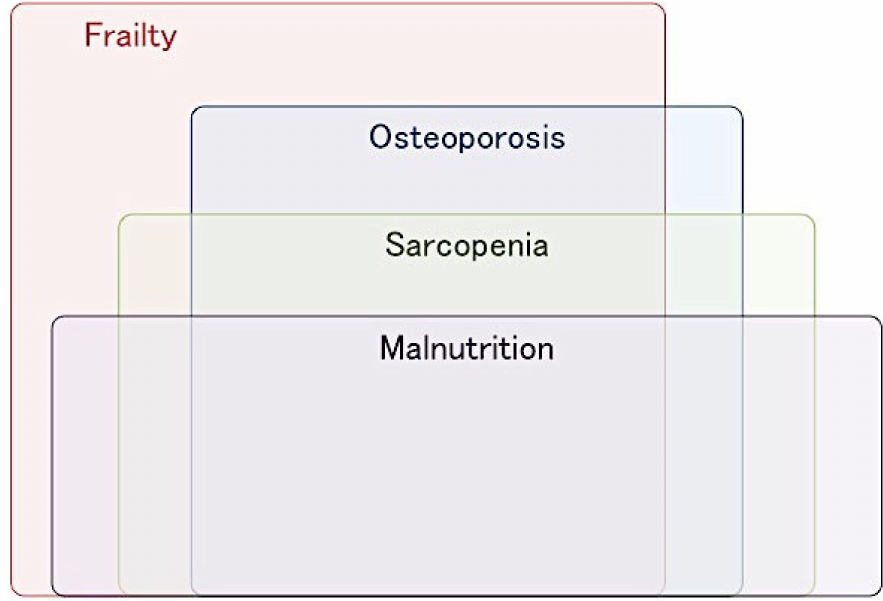
Figure 1. The overlapping geriatric nutritional problems in patients with fragility hip